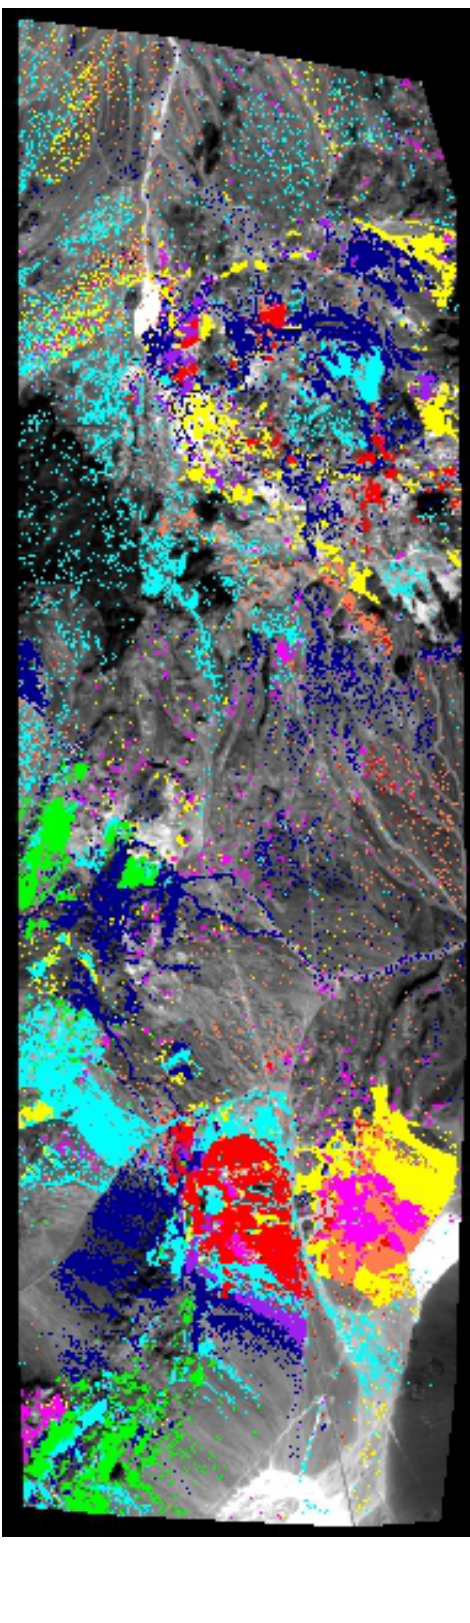
Figure 2. Left: SWIR mineral map for the full Cuprite-Goldfield 15 m spatial resolution scene generated from Airborne Visible/Infrared Imaging Spectrometer (AVIRIS) data by geocorrecting to ASTER and spectrally resampling to HyspIRI spectrally response. Right: SWIR mineral map for the full Cuprite-Goldfield HyspIRI 60 m simulated